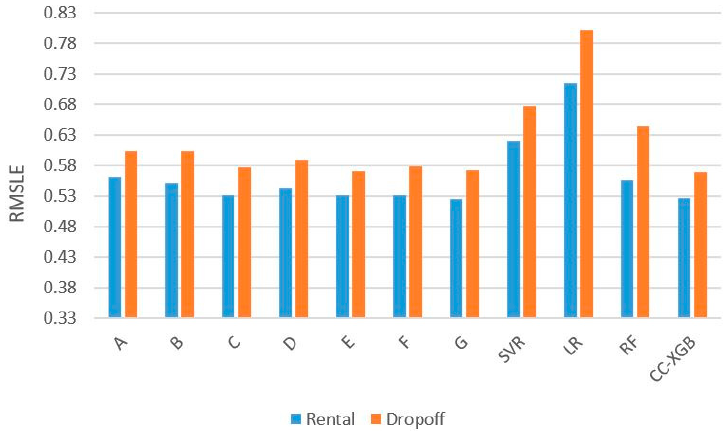
Figure 14. Random prediction for rental/drop-off.